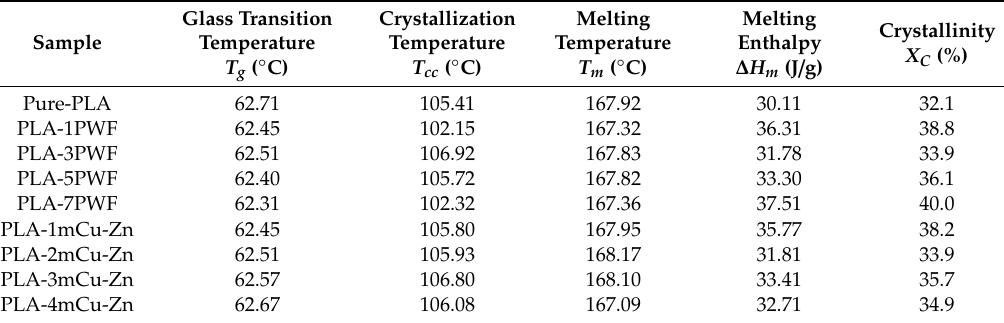
Figure9. Differentialscanningcalorimetry(DSC)curvesofPWF / PLAcomposites( a )andmCu-Zn / PWF / PLA Figure 9. Differential scanning calorimetry (DSC) curves of PWF/PLA composites ( a ) and mCu ‐ composites with 5 wt.% PWF ( b ). Zn/PWF/PLA composites with 5 wt.% PWF ( b ). Table 4. DSC data of PWF / PLA and mCu-Zn / PWF / PLA Table 4. DSC data of PWF/PLA and mCu ‐ Zn/PWF/PLA composites.